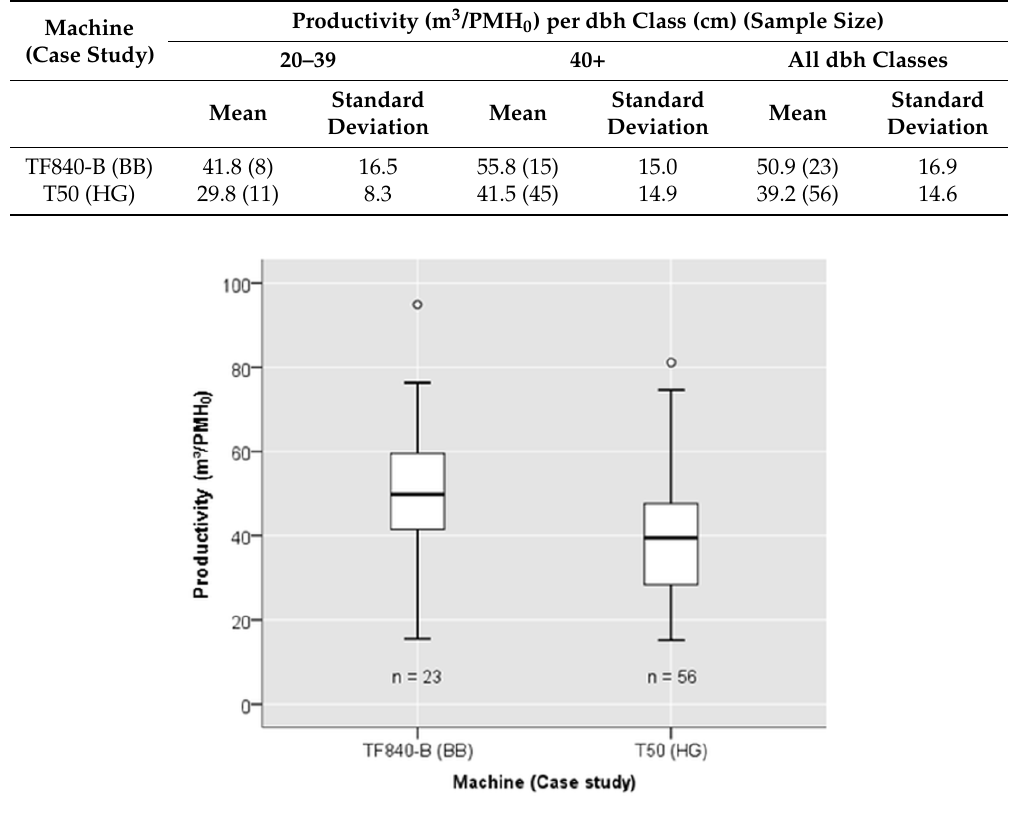
Figure 7. Distribution of productivity for the two machines (case studies) in the motor-manual (MM) group.